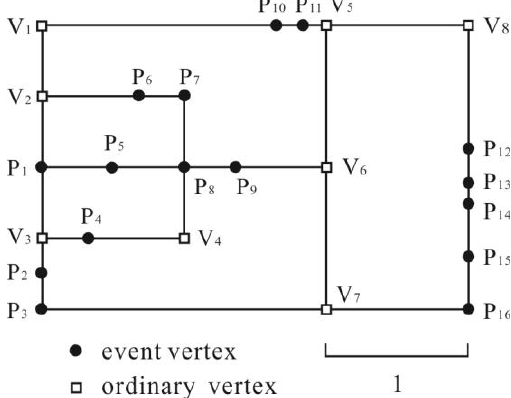
Figure 3. An un directed planar graph N = (V∪P, E, W) was generated for the simulated dataset. P is the event vertex, representing the event points. V denotes ordinary vertices, representing the location where the road segments intersect. An ordinary vertex will not be created in the segments’ intersection if an event vertex already exists, such as P 1 . E is the edge, representing the road segments between the two vertices. W is the weight of edges, which is defined as the length of edges in the study.